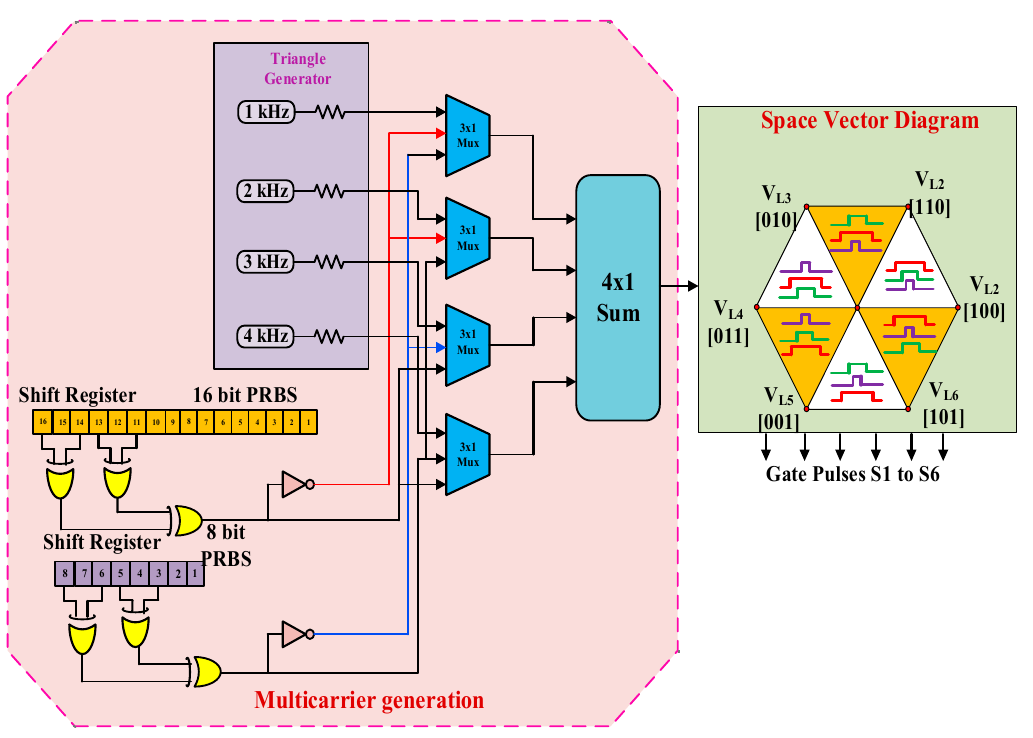
Figure 4. Proposed MCRSVPWM scheme.